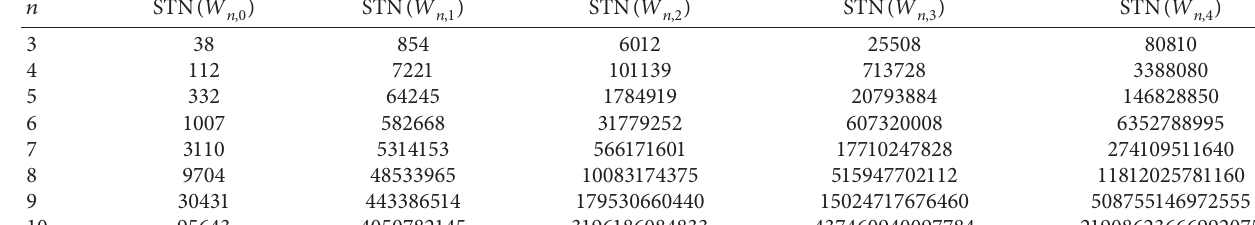
) of the k regular wheel graphs W n,k